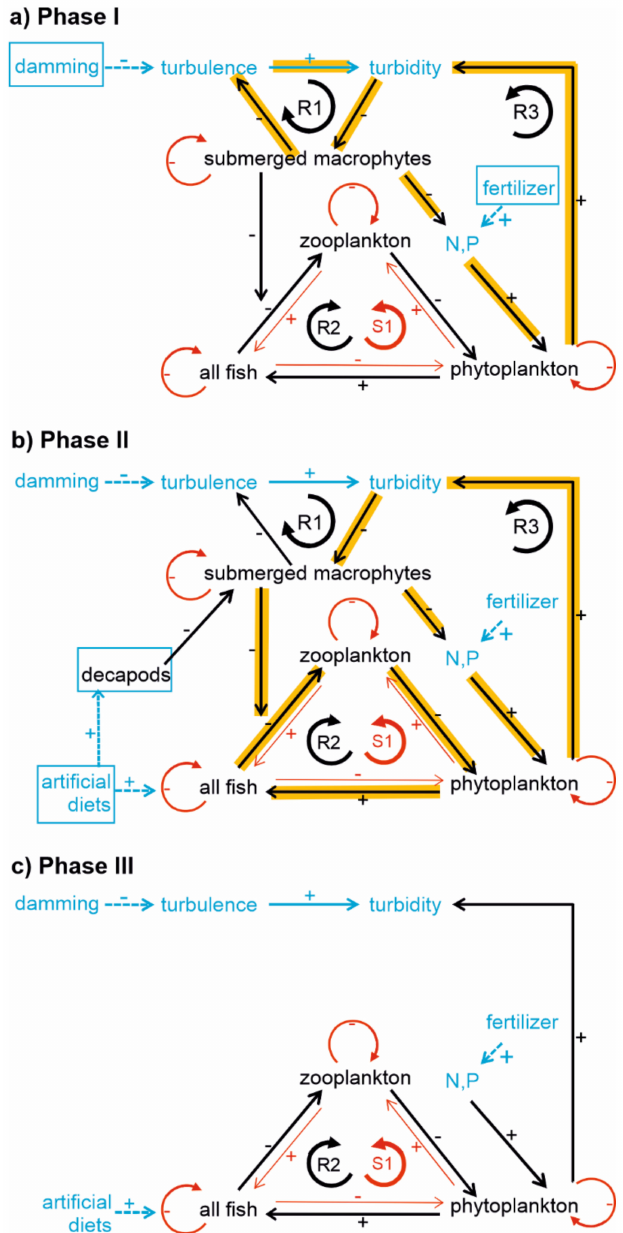
Figure 7. Diagrams of reconstructed dynamic changes in Taibai Lake in the last decades. Straight arrows show positive (+) and negative ( − ) interactions. New interventions are shown in blue boxes. Yellow-highlighted arrows indicate triggering forces that stimulate circular interactions. In a closed- loop, an odd number of negative interactions means a negative or stabilizing feedback loop (red arrows); an even or zero number of negative interactions means a positive or reinforcing loop (“R”, black arrows). ( a ) inferred feedback loops around 1956; ( b ) modified feedback loops from 1960s to 1990s; ( c ) simpler feedback loops because links related to submerged macrophytes drop